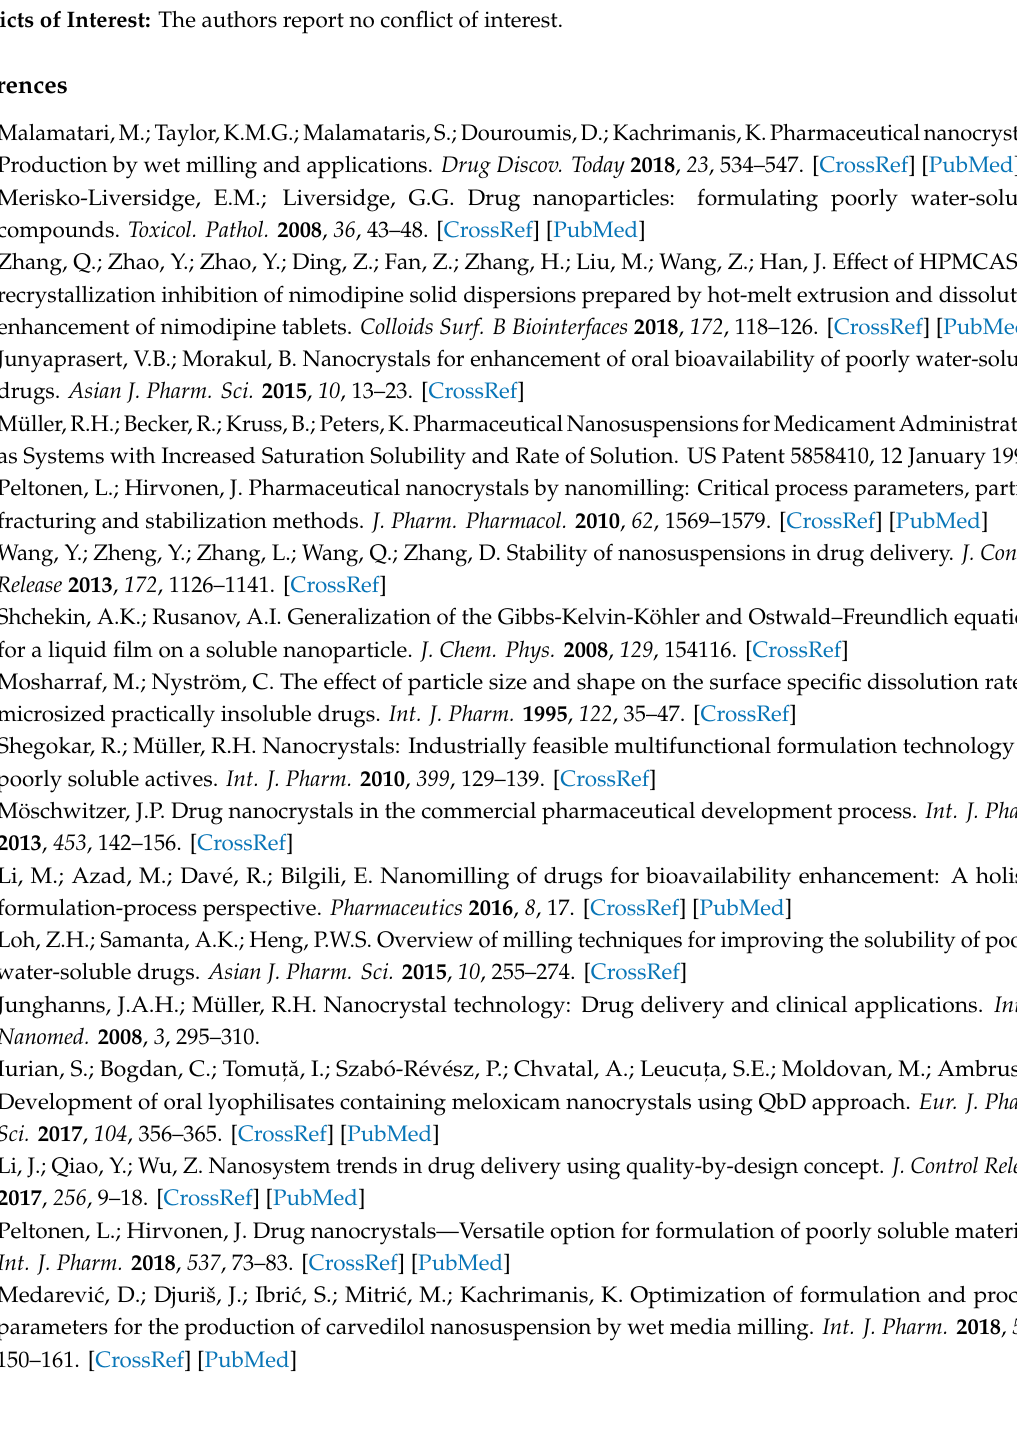
critical process parameters (CPPs) on critical quality attributes (CQAs). Table S2: Fit summary for responses Y 1